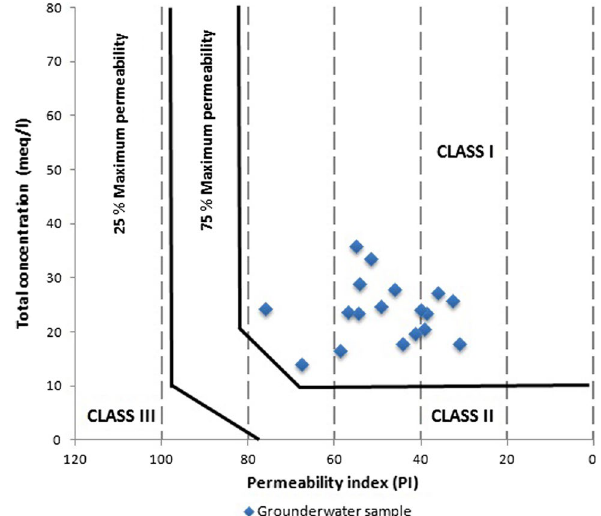
Fig. 8 Doneen diagram for groundwater